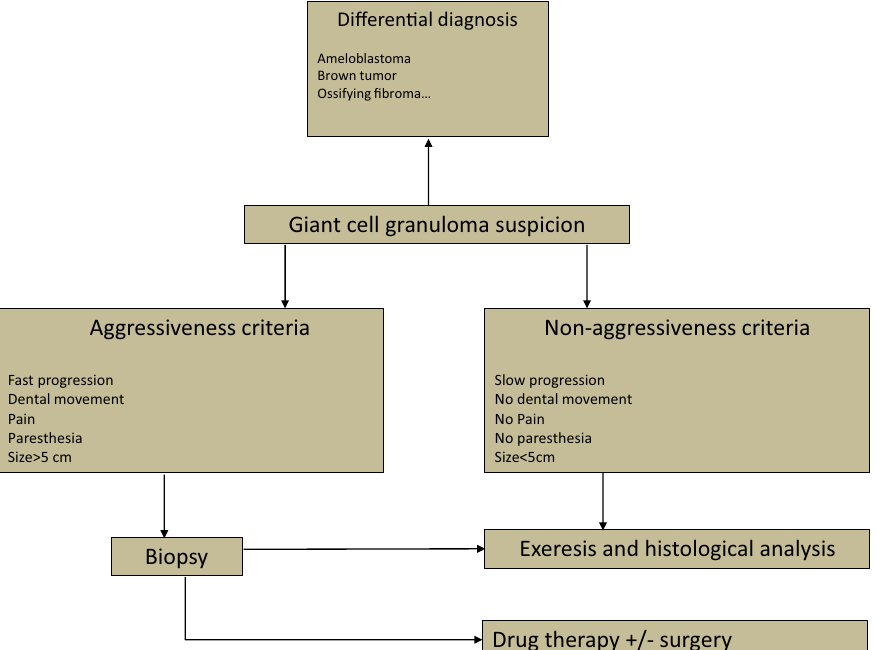
Fig. 3. Decision tree for the diagnosis of giant-cell granuloma (GCG). GCG management will depend on whether or not the lesion meets the criteria for